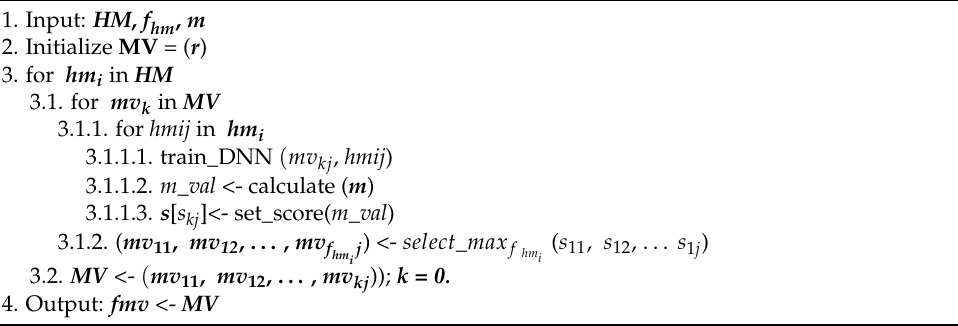
Table 2. Pseudocode of the proposed tuning